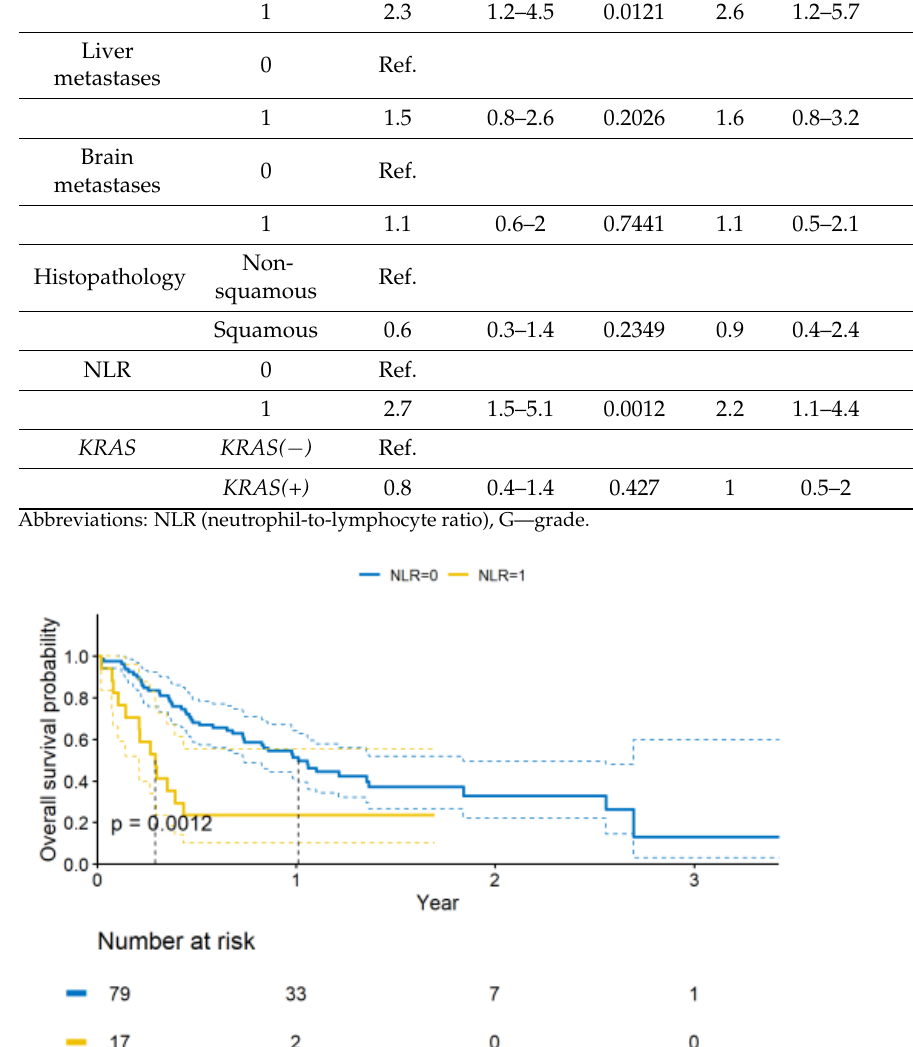
8 Figure 4. Probability of survival in the entire analyzed group.